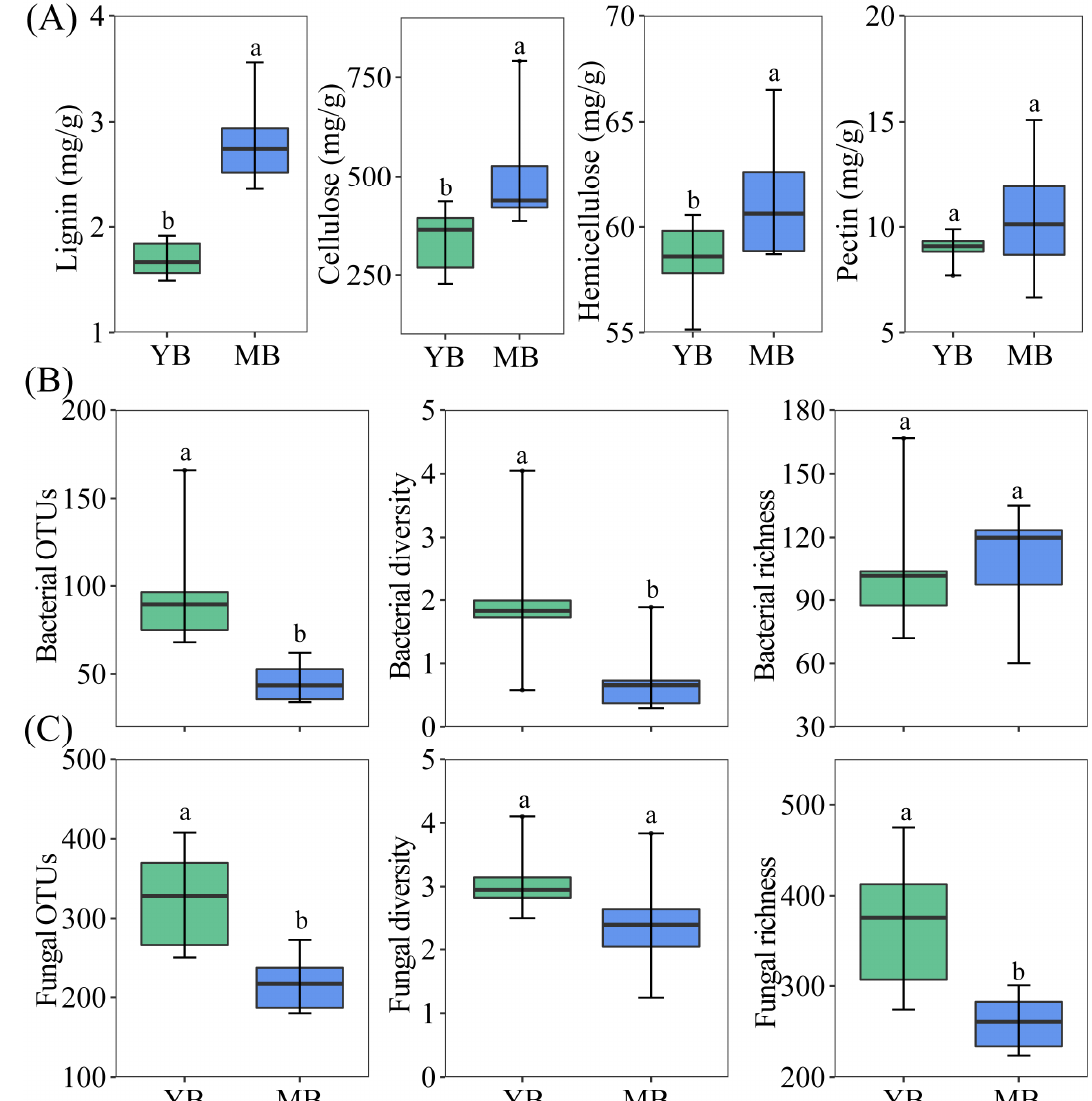
Figure 2. Lignification indices ( A ) and diversity of endophytic bacterial ( B ) and fungal ( C ) communities in young and mature branches of Nitraria tangutorum . YB: young branches; MB: mature branches. The letters a and b indicate significant differences.